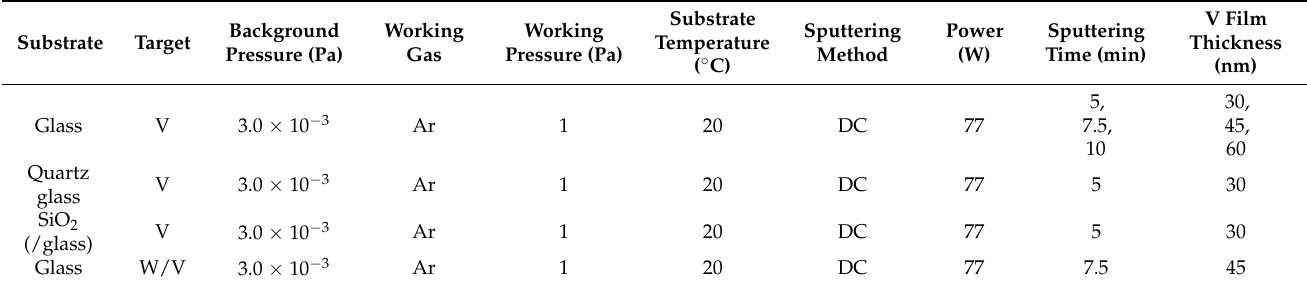
Table 1. Preparation parameters of V-based metal films by magnetron sputtering.